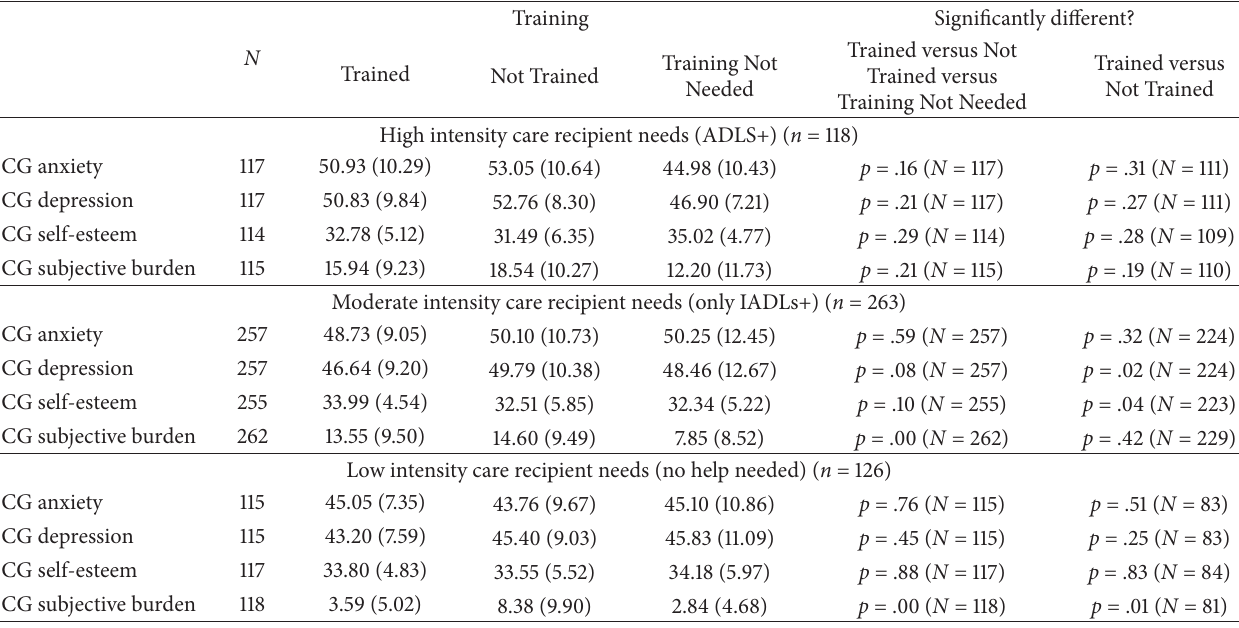
Table 4: Differences in caregiver mental health based on training received for navigating the VA or DoD based on intensity of care recipient’s needs. Training Significantly different? Trained versus Not N Training Not Trained versus Trained Not Trained Trained versus Needed Not Trained Training Not Needed High intensity care recipient needs (ADLS+) ( n =